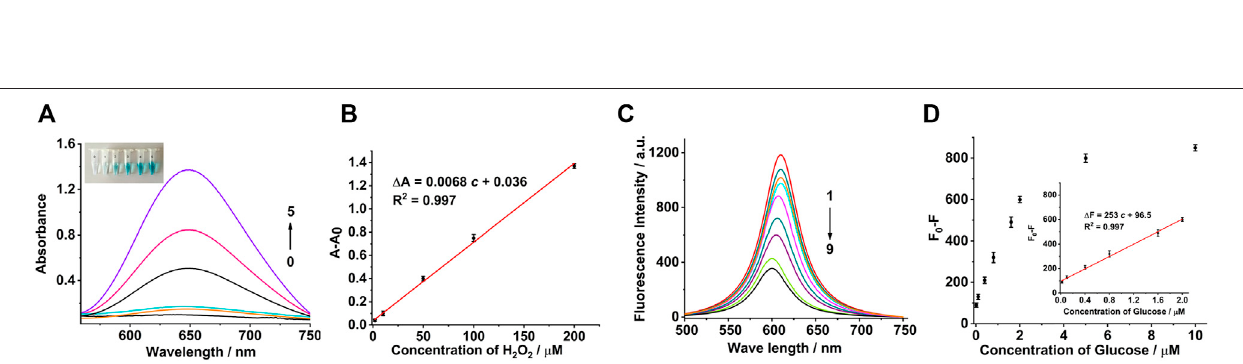
FIGURE4| H 2 O 2 andglucoseassaysusingCo 3 O 4 nanosheetmimetics. (A) UV-VisabsorptionspectrainthepresenceofdifferentH 2 O 2 concentrations:(0)0,(1)2, (2) 10, (3) 50, (4) 100, and (5) 200 μ M. The inset photograph shows the visible color change of the reaction system, accordingly. (B) Calibration curve corresponding to theabsorbance(atthewavelengthof650 nm)asafunctionofH 2 O 2 concentration. (C) FluorescencespectraofRu(bpy) 32+ inthepresenceofdifferentconcentrationsof glucose: (1) 0, (2) 0.02, (3) 0.1, (4) 0.4, (5) 0.8, (6) 1.6, (7) 2.0, (8) 5.0, and (9) 10.0 μ M. (D) Calibration curve corresponding to the fl uorescence intensity (at the emission wavelength of 610 nm) as a function of glucose concentration. Inset shows the linear relationship between the fl uorescence intensity and the glucose